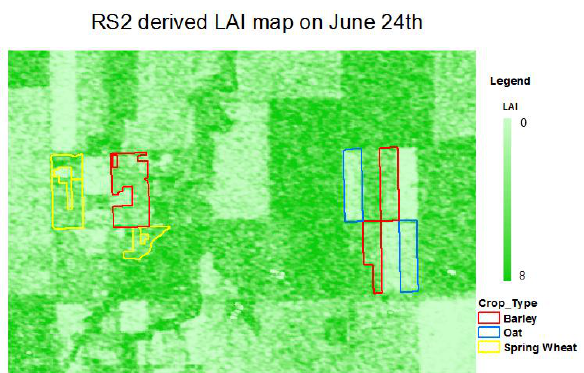
Figure 2. Model fit of LAI and soil moisture to entropy